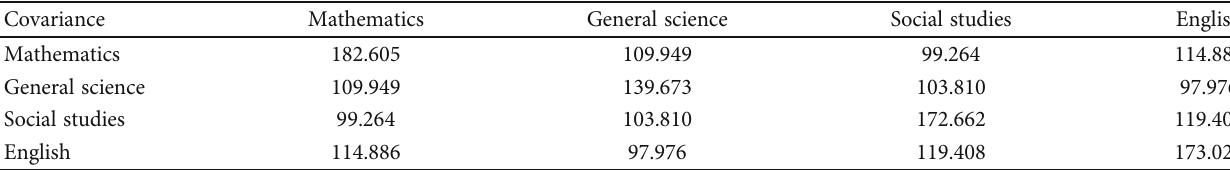
Table 8: The covariance for total rural students.